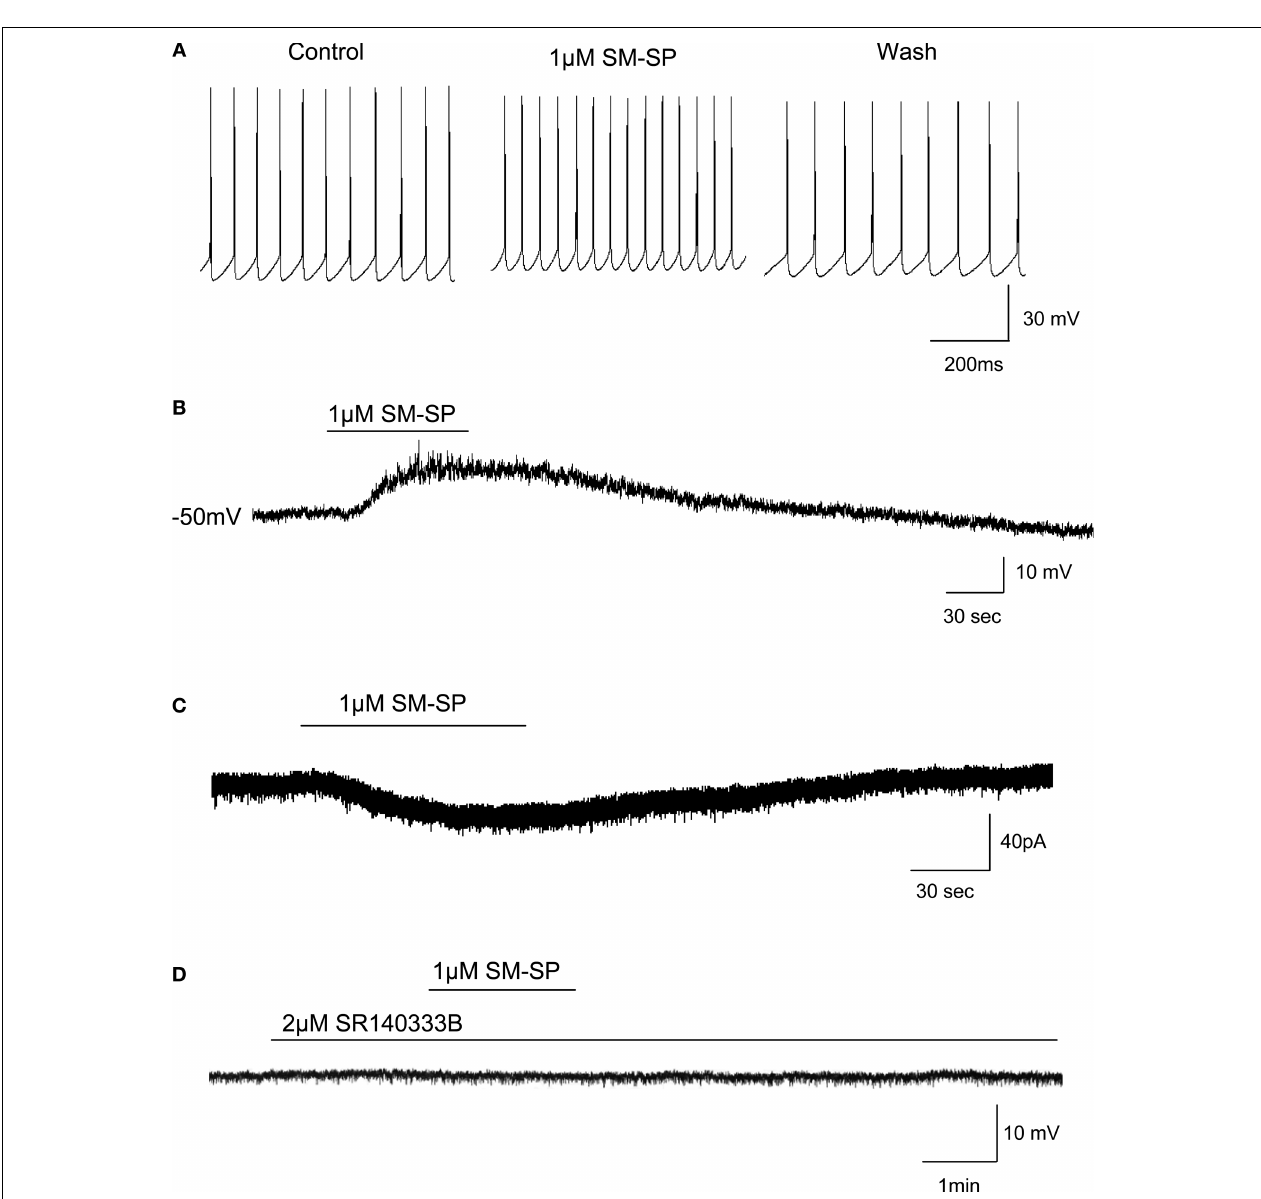
FIGURE 1 | Effects of SM-SP on globus pallidus neurons. (A) Application of 1 µM SM-SP increased spontaneous fi ring rate of globus pallidus neuron. (B) In the presence of 0.5 µM TTX, 1 µM SM-SP depolarized globus pallidus neuron. (C) Inward current induced by 1 µM SM-SP in the presence of TTX under voltage- clamp recordings. (D) The presence of neurokinin-1 receptor antagonist, SR140333B, blocked SM-SP-induced depolarization.